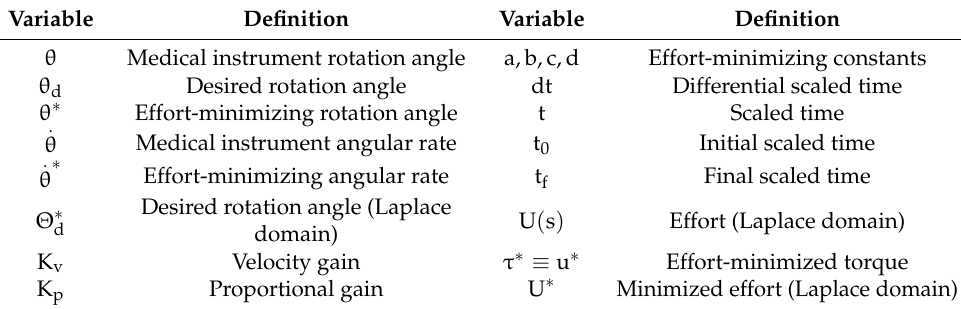
Table 5. Proximal variable definitions 1